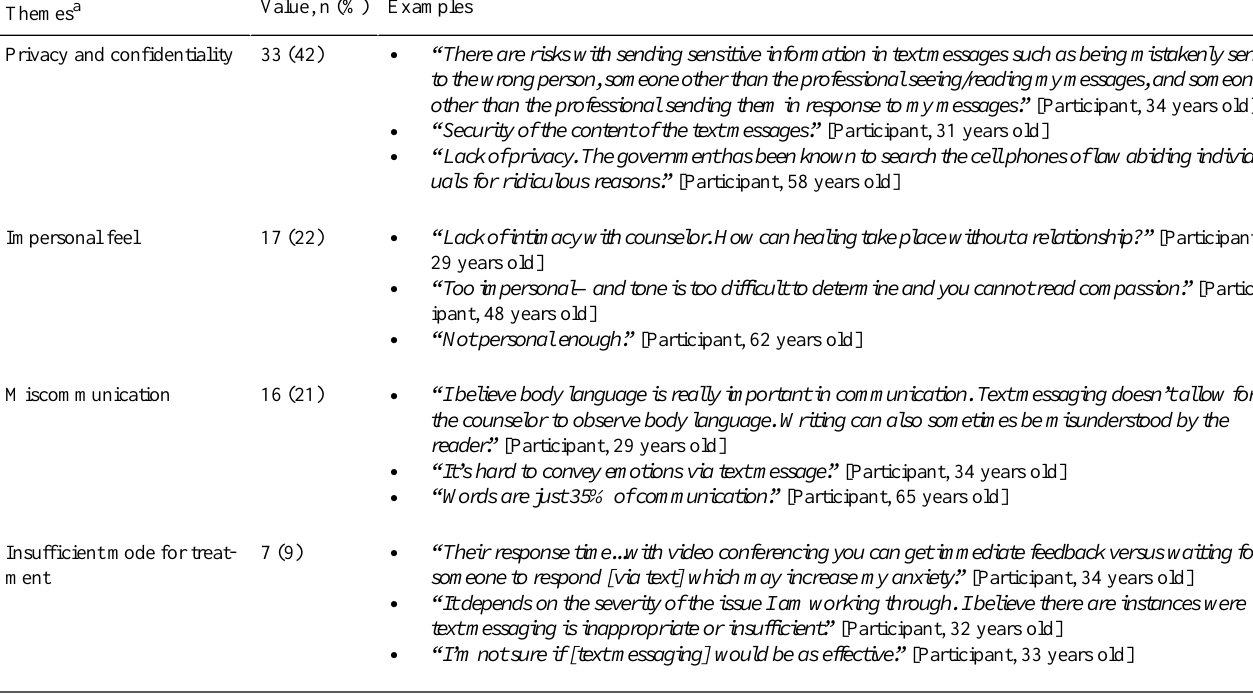
Table 4. The most common concerns about using text messaging to communicate with a professional (N=78). ExamplesValue, n (%)Themes